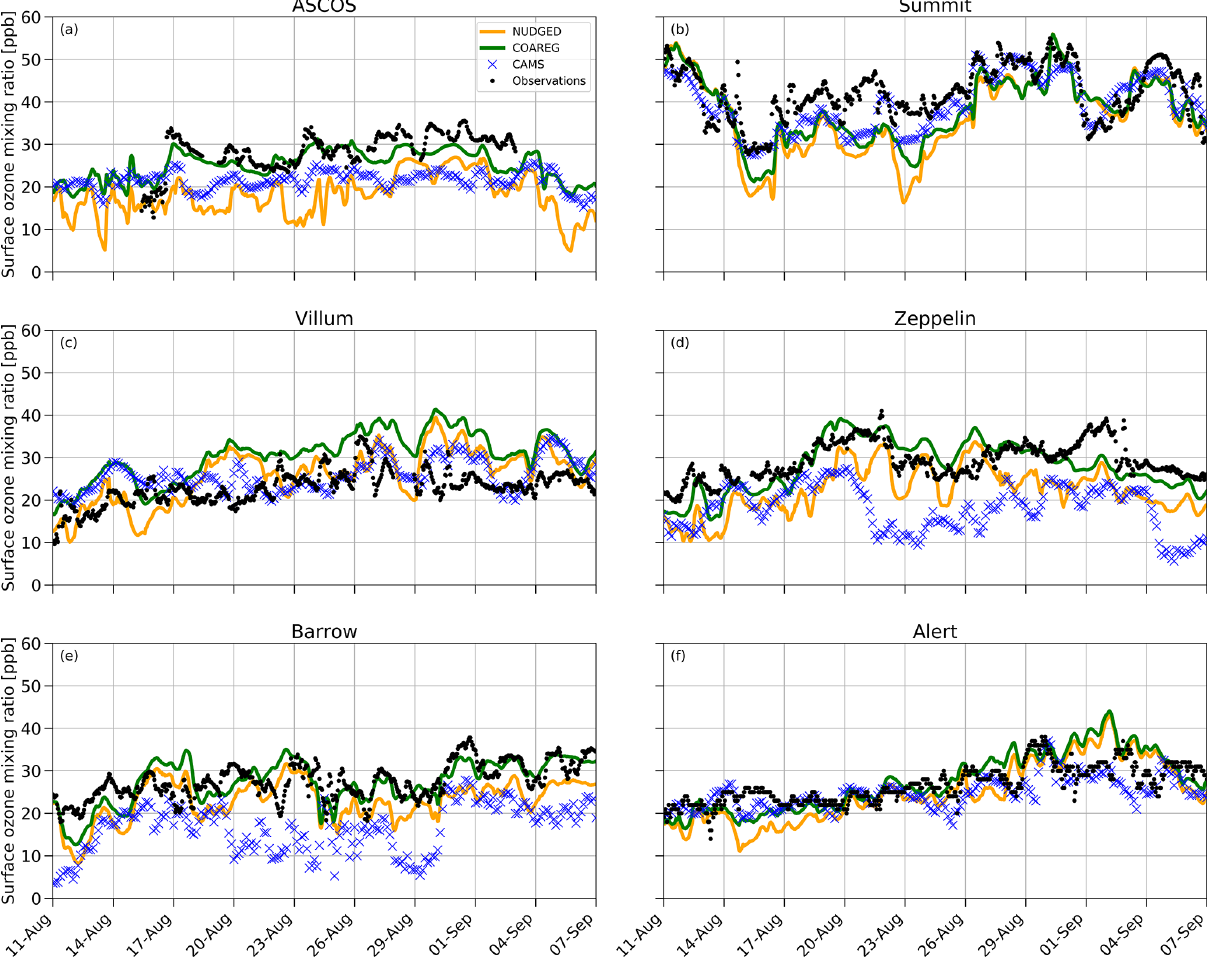
Figure 5. Temporal evolution of hourly surface O 3 mixing ratios (ppb) for the NUDGED (yellow) and COAREG (green) runs, CAMS data (blue crosses) and observations (black dots) at ASCOS ( ∼ 87.4 ◦ N, ∼ 6.0 ◦ W), Summit (72.6 ◦ N, 38.5 ◦ W), Villum (81.6 ◦ N, 16.7 ◦ W), Zeppelin (78.9 ◦ N, 11.9 ◦ E), Barrow (71.3 ◦ N, 156.6 ◦ W) and Alert (82.5 ◦ N, 62.3 ◦